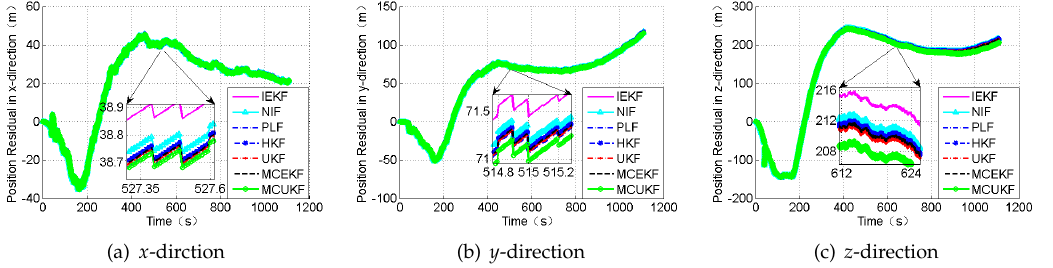
Figure 12. The position residual under the condition of the Gaussian mixture noises.